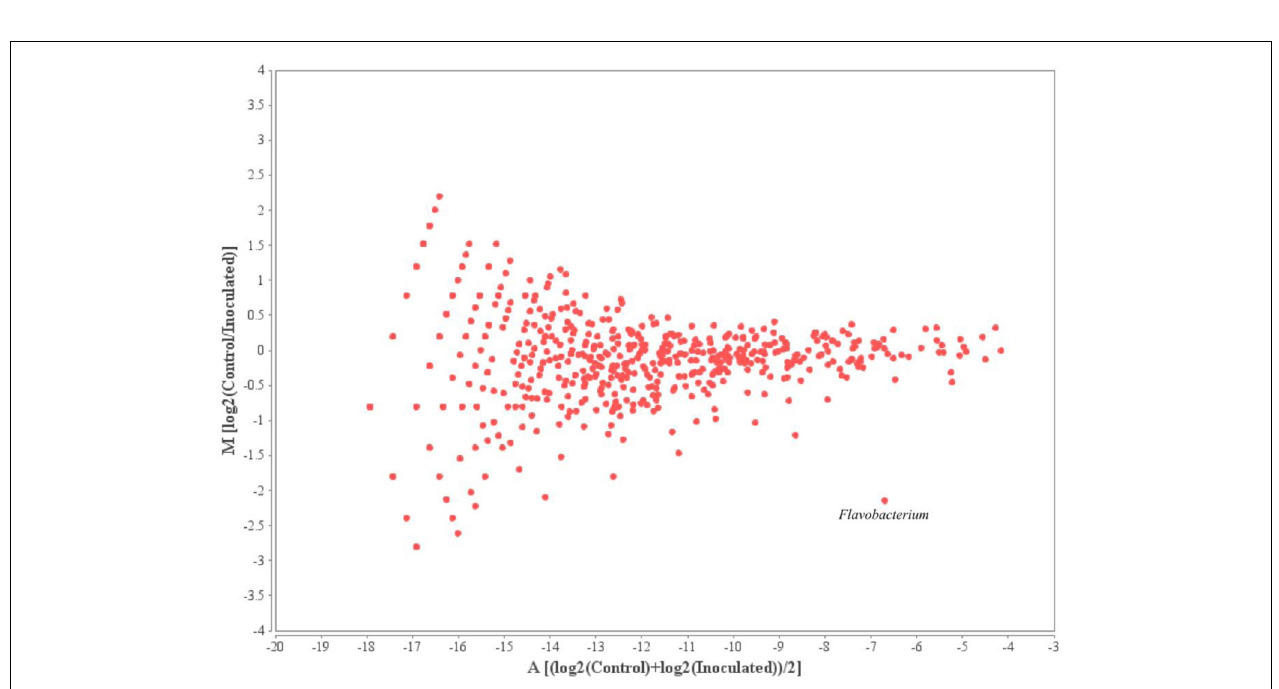
FIGURE 9 | MA-Plot visualizing the values of annotated genera within the t2 samples. Log2(Control/Inoculated) indicates the fold-changes in the abundances of annotated genera between the two samples; (log2(Control) + log2(Inoculated))/2 shows the average abundance of an annotated genus.